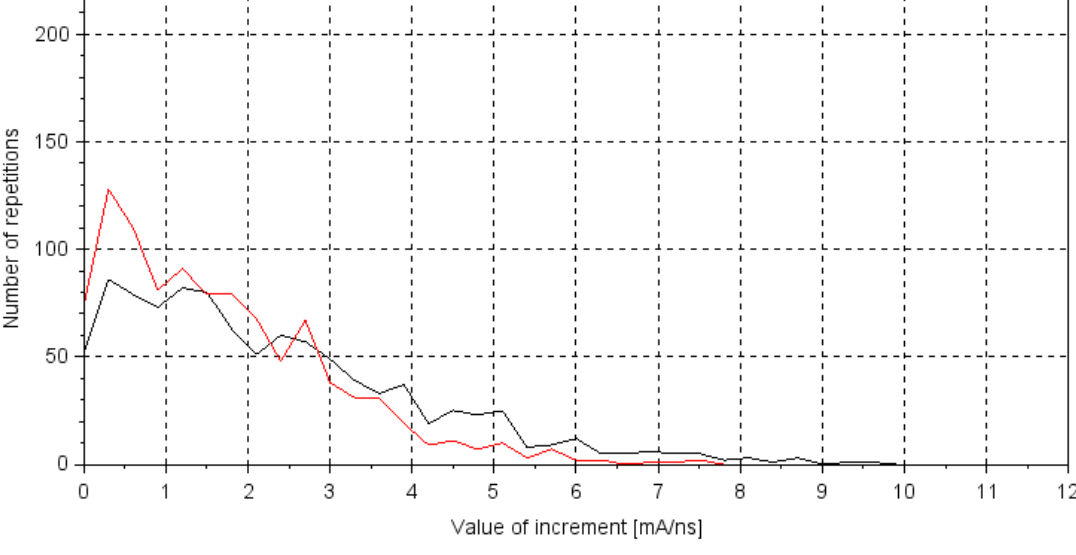
Figure 15. Figure showing 1 kpts decompositions of signals at different distances of electrodes, with 1 mm (black) and 1 cm (red) (conditions: voltage of 1.6 kV DC and current of 1 A DC at each measurement).